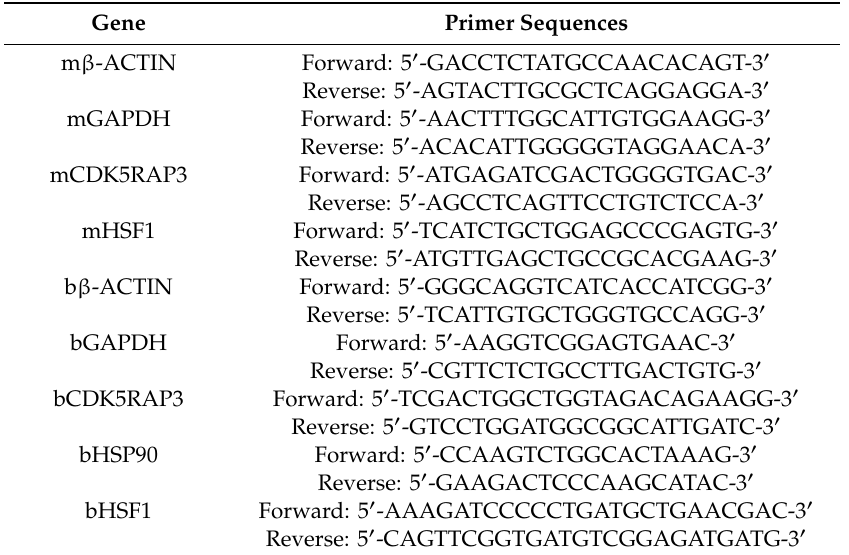
Table 1. Table 1. The primers used for qRT-PCR analysis. Gene Primer